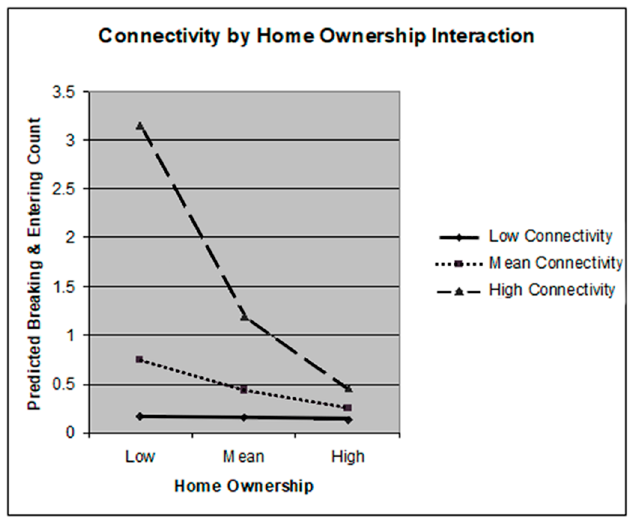
Figure 1. Plot of the interaction of connectivity and homeownership on breaking and entering. Note: When connectivity is high and percentage of homeownership is high, crime rate is lower.